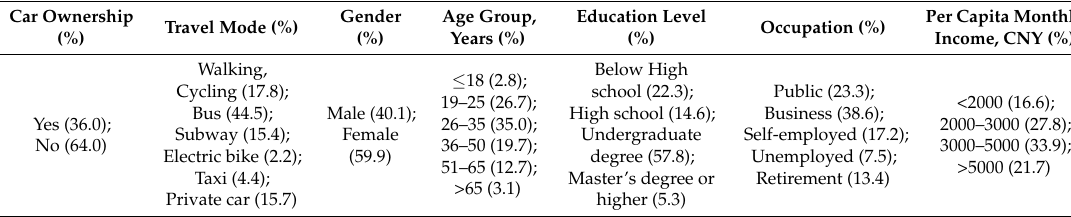
Table 3. Characteristics of the survey